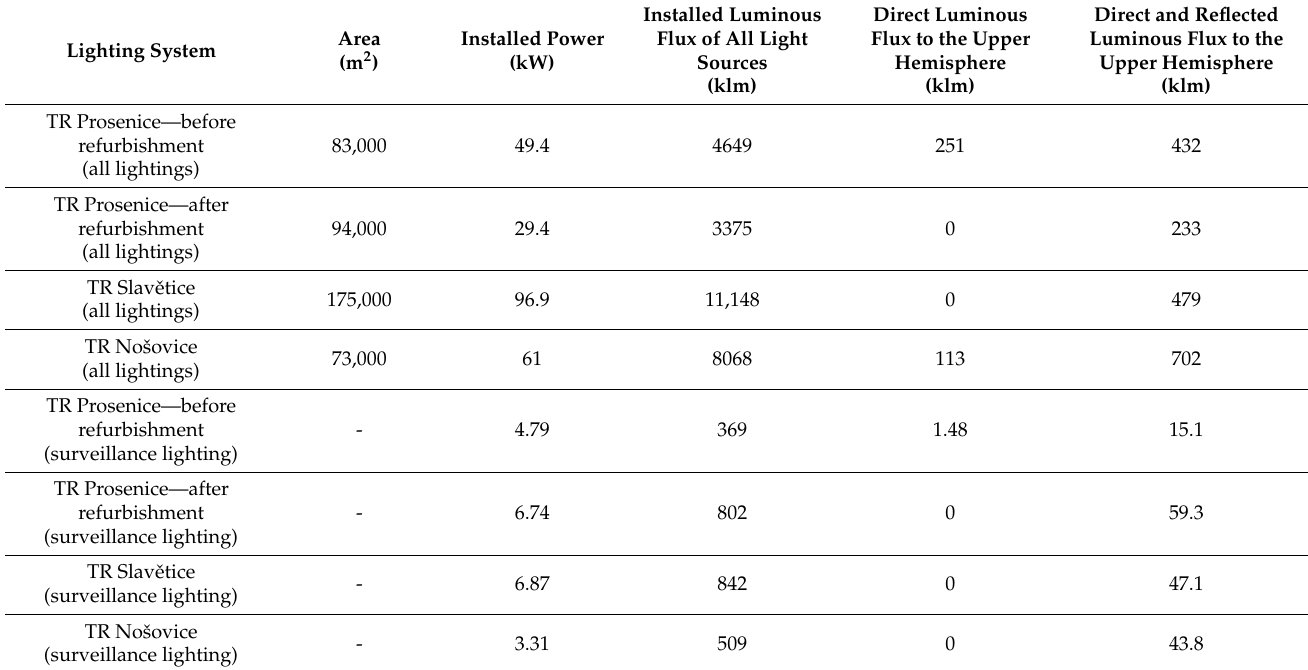
Table 12. Final comparison of the light emissions from lighting of outdoor workplaces versus light emissions from road-lighting